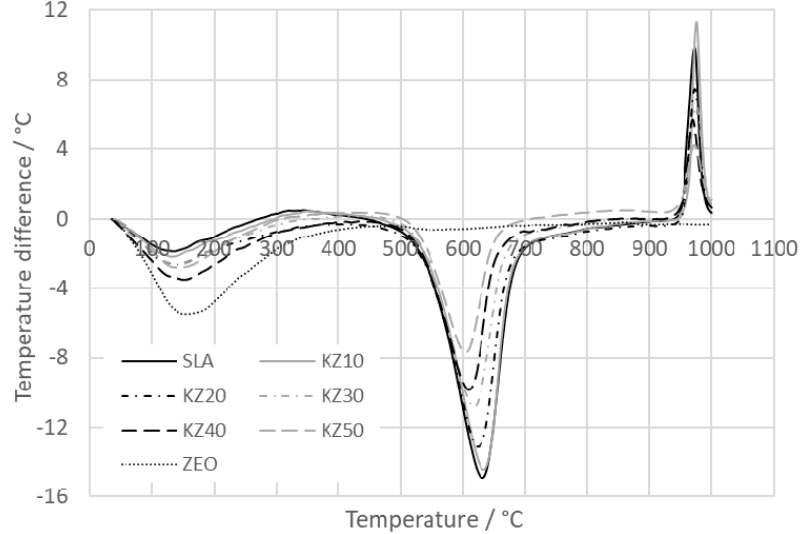
Figure 1. Differential thermal analysis (DTA) of the studied samples.